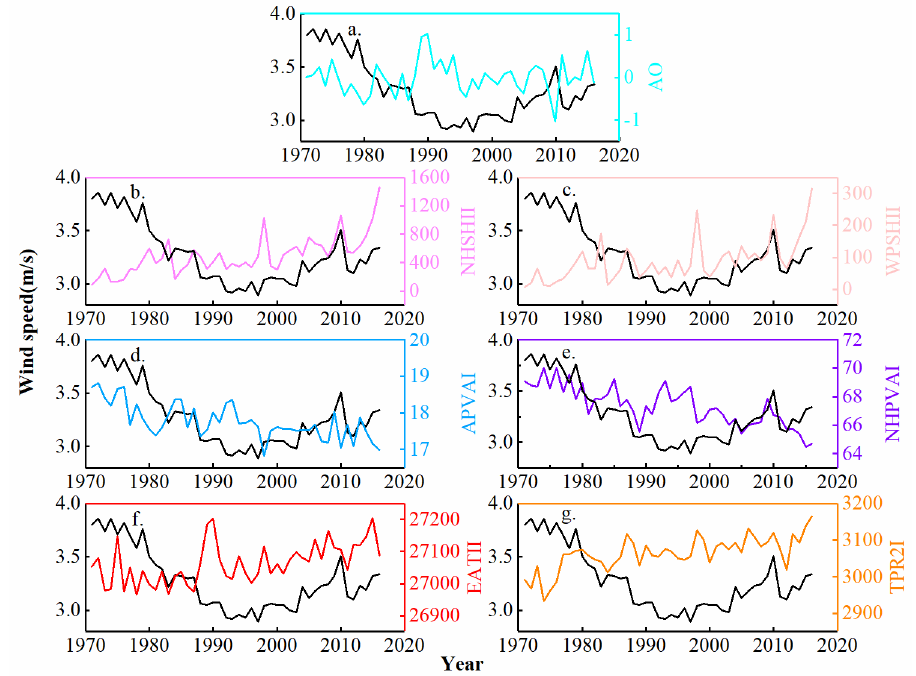
Figure 5. Change process of wind speed and ( a ) AO, ( b ) NHSHII, ( c ) WPSHII, ( d ) APVAI, ( e ) NHPVAI, ( f ) EATII and ( g ) TPR2I in the BJD.